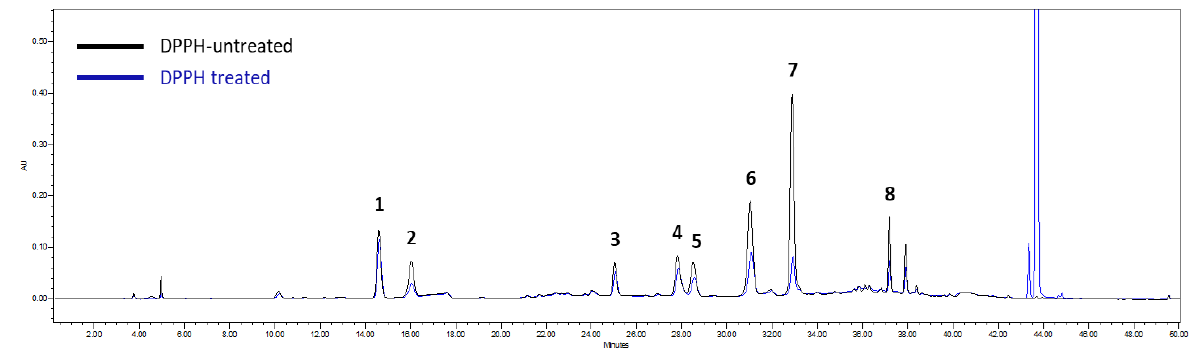
Figure 5. Chromatogram of HPLC-DPPH for screening antioxidants from the extract of I. rotunda twigs. Compounds 1 – 8 were identified as antioxidants by the HPLC-DPPH screening method. The HPLC peak areas of these eight marker compounds reduced after reaction with DPPH radicals (DPPH group) compared with those from the DPPH-free group. Table 3. Antioxidant effect of eight marker compounds on DPPH radical. Marker